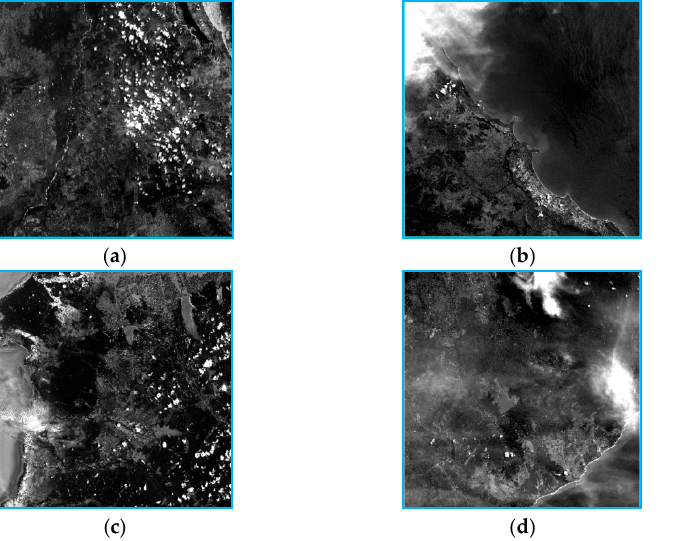
Figure 10. Database display: ( a ) short coastline; ( b ) long coastline; ( c ) multiple coastlines; and ( d ) cloud-sheltered coastline.